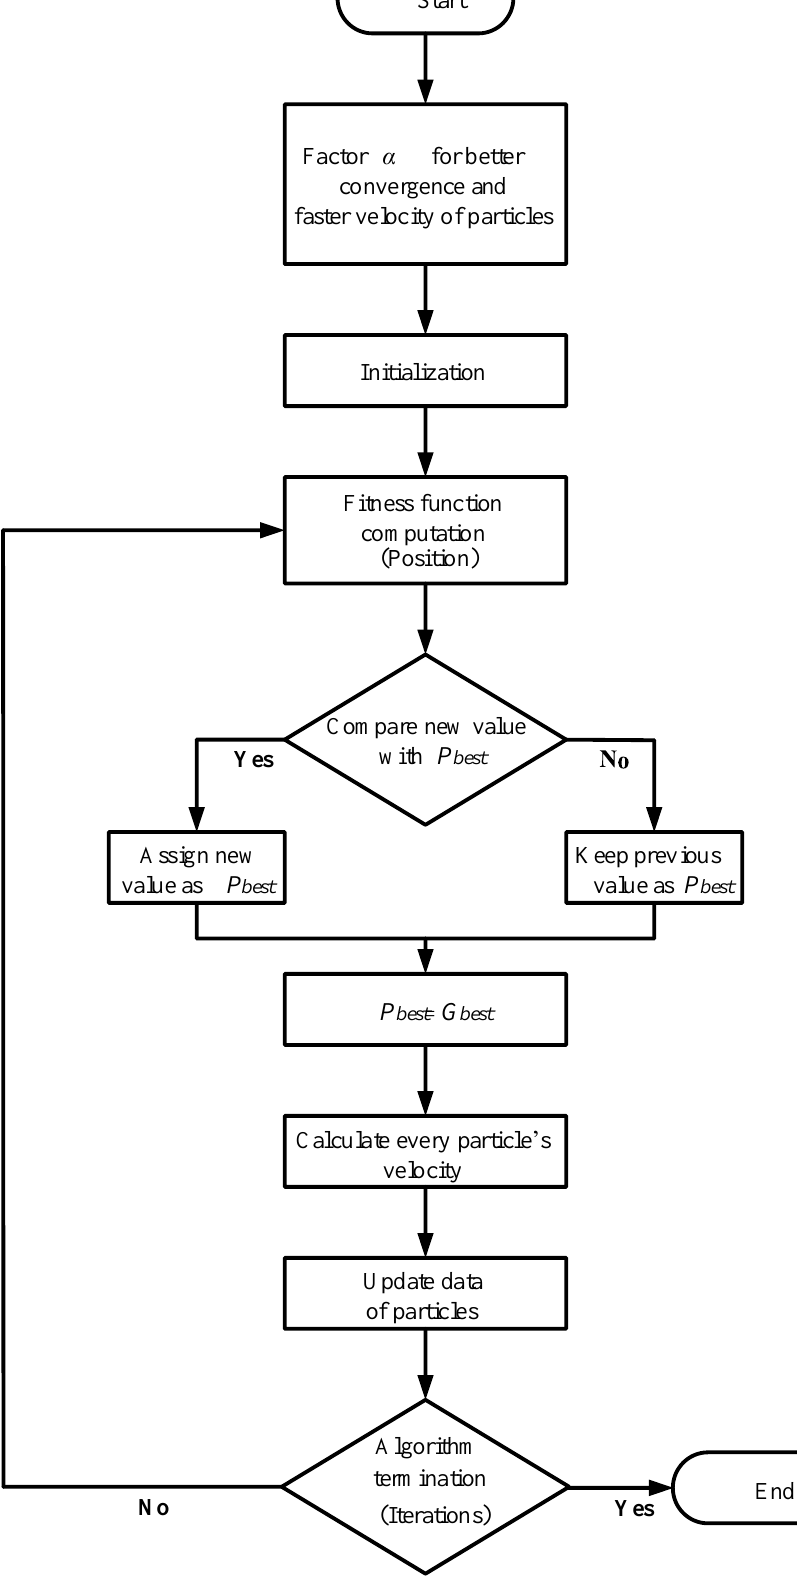
Figure 5. Flow chart of the HPSOBA.